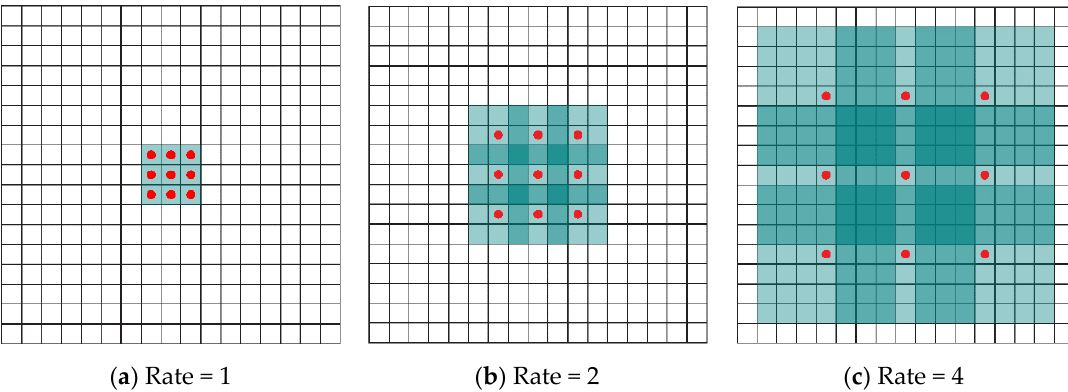
Figure 4. Receptive field size of different dilated convolutions with rates of 1, 2, and 4. ( a ) Rate = 1, ( b ) Rate = 2, ( c ) Rate = 4.